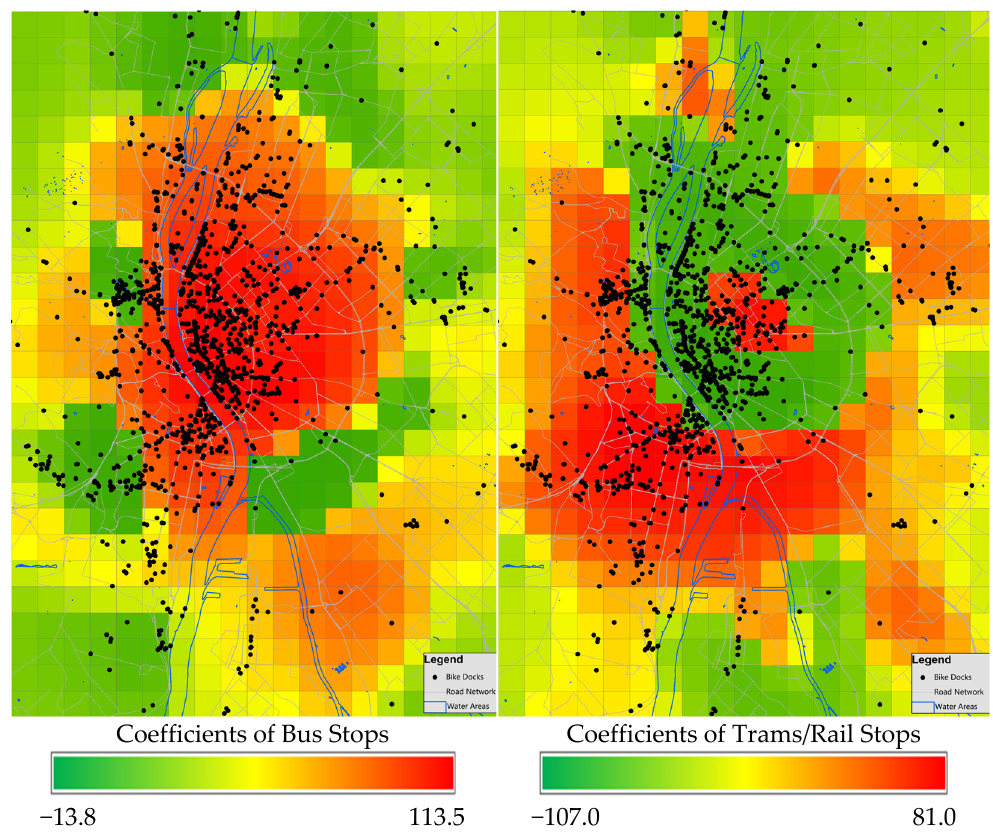
Figure 1. Coefficients of Bus, Tram/Rail stops.